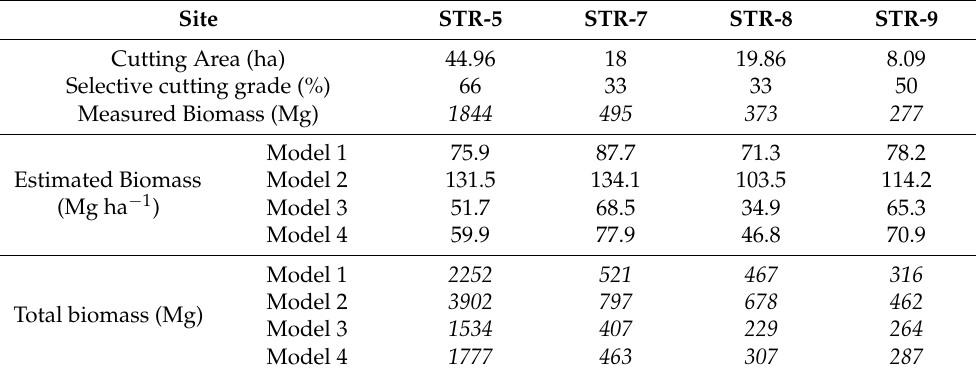
Table 6. Characteristics of cuts made in STR-5, STR-7, STR-8, and STR-9